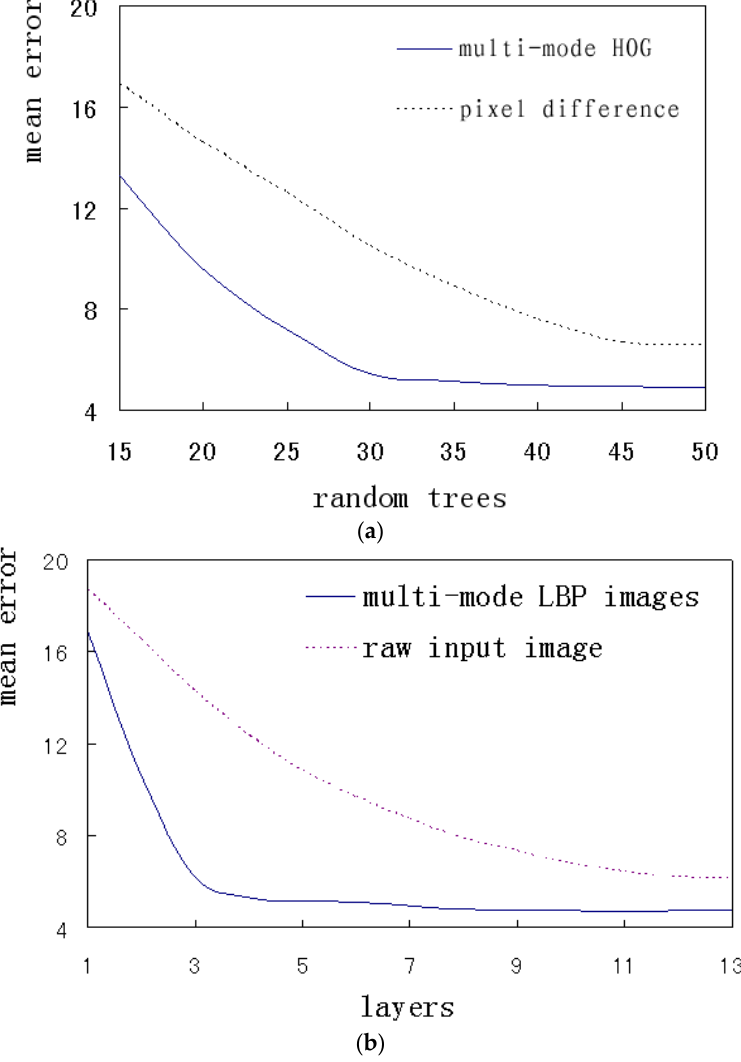
Figure 13. The error comparisons of the different features. ( a ) The error variation with the number of random trees; ( b ) The error variation with the number of CNN layers.